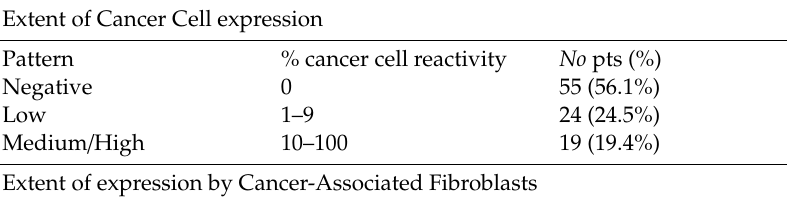
Table 1. Expression patterns of iNOS in tumor